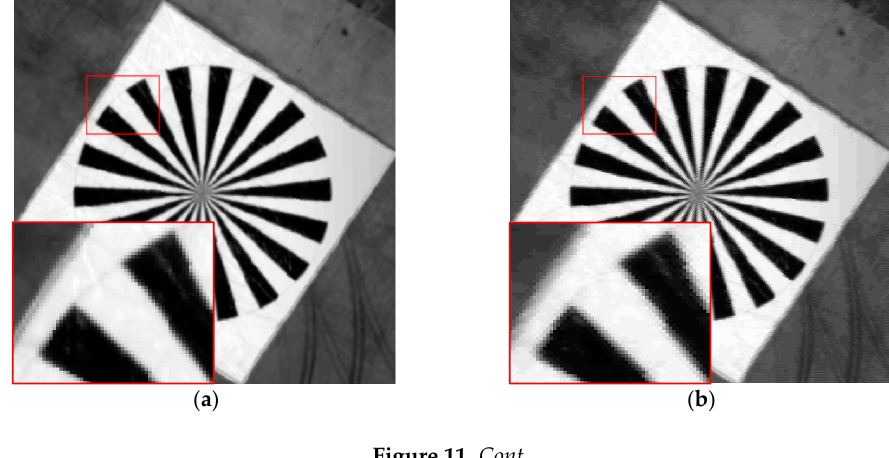
Figure 11. Cont. Figure 11.